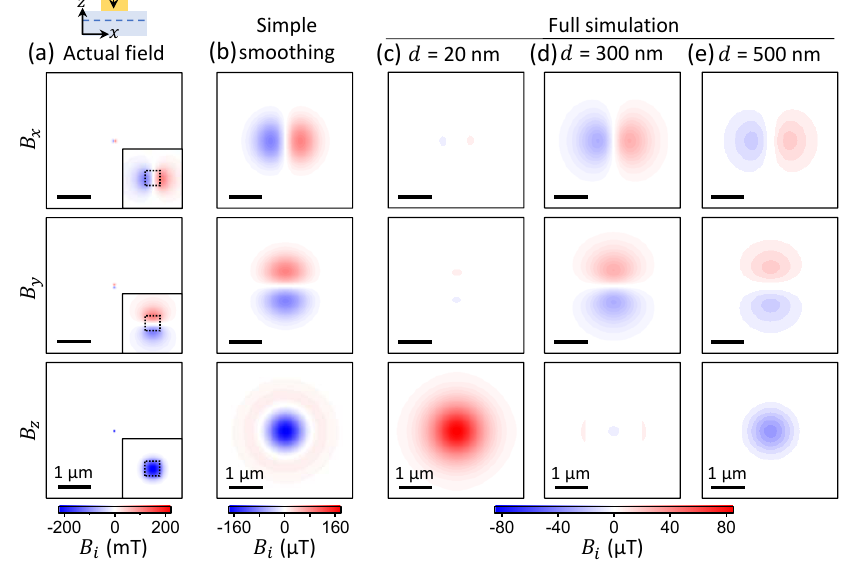
Figure 6. ( a ) Magnetic field calculated at a stand-off d = 20 nm for a 50 × 50 × 50 nm 3 particle magnetised along z with M s = 10 6 A/m (see schematic). Inset: magnified view near the particle, whose footprint (50 × 50 nm 2 ) is indicated by a dashed box. ( b ) Apparent magnetic field obtained by convolving the actual field ( a ) with a Gaussian spot of width 1 µ m (FWHM). ( c – e ) Apparent magnetic field obtained by simulating the full measurement process, with d = 20 nm ( c ), d = 300 nm ( d ) and d = 500 nm ( e